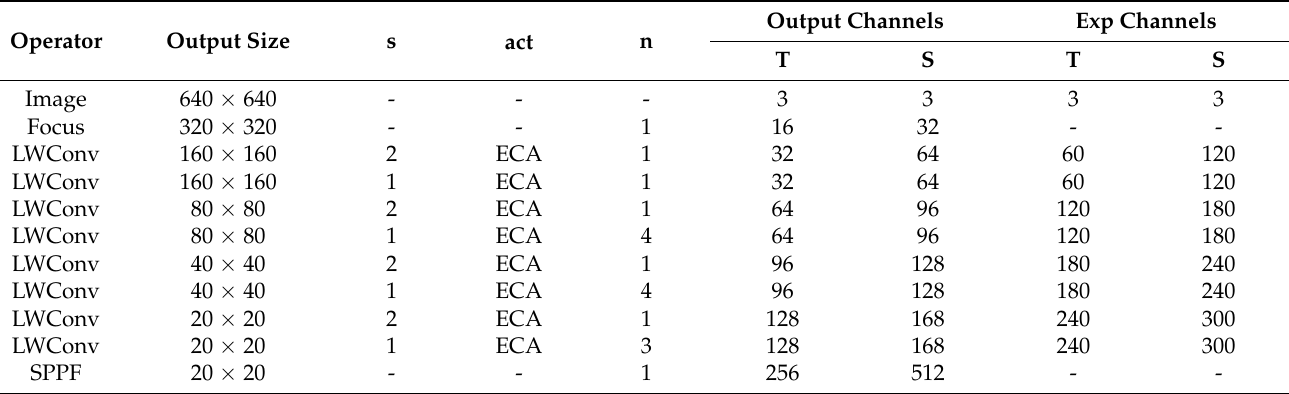
Table 1. We determined the specific width, depth factors, and expansion rate of the LWNet through experiments. Table 1. Specification for a